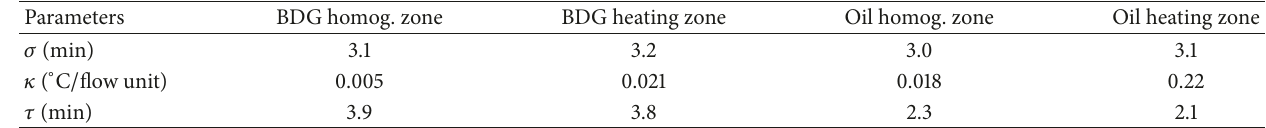
Table 1: Parameters found for 1st-order model for BDG and oil in each control zone.